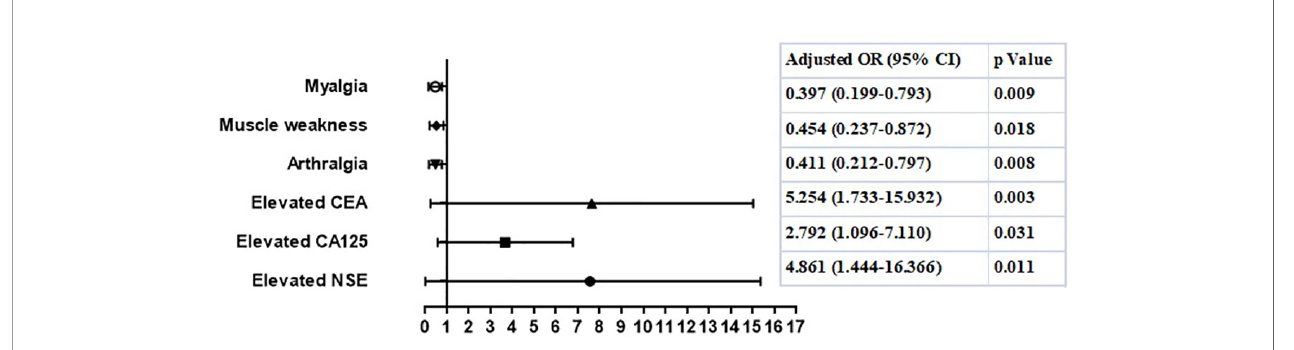
FIGURE 2 | Risk factors of RP-ILD in patients with